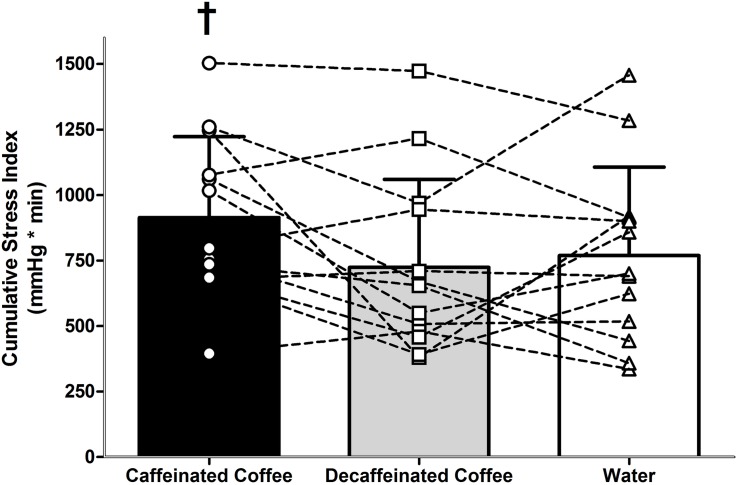
Tolerance to progressive central hypovolemia, via lower body negative pressure, as expressed as cumulative stress index (CSI). Tolerance to central hypovolemia was greater in the caffeinated coffee trial relative to water (P = 0.048) and decaffeinated coffee (P = 0.033). Data are displayed in bars represent mean ± standard deviations for thirteen participants. Data displayed overlaid onto bars as squares, circles, and triangles represent individual CSI values for each of the thirteen participants in the caffeinated coffee, decaffeinated coffee, and water trials, respectively. † different from decaffeinated coffee and water trials (both P < 0.05).